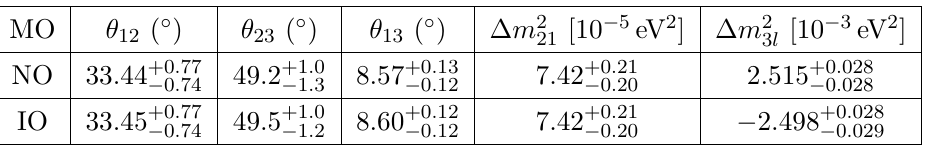
Table 2 . Preferred values from a recent global fit to oscillation data [99]. ∆ m 2 positive and ∆ m 2